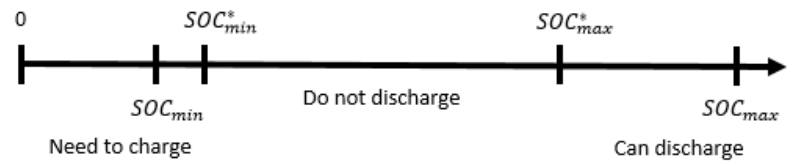
Figure 4. Plug-in electric vehicle (PEV) battery charging and discharging strategy .